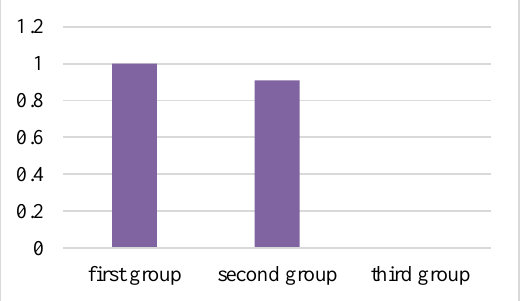
Figure 7. The sadness mode in autistic children